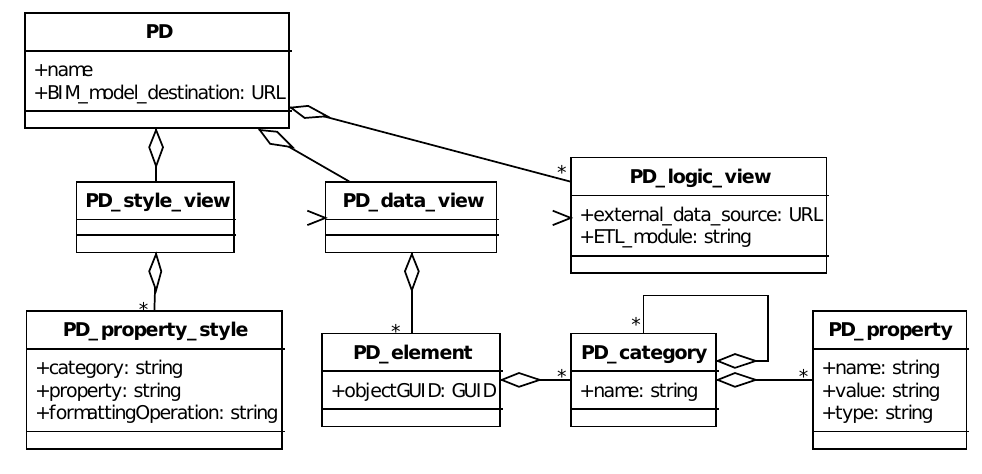
Figure 11. B2G PD concept diagram (UML). Table 5. P2G PD class description.